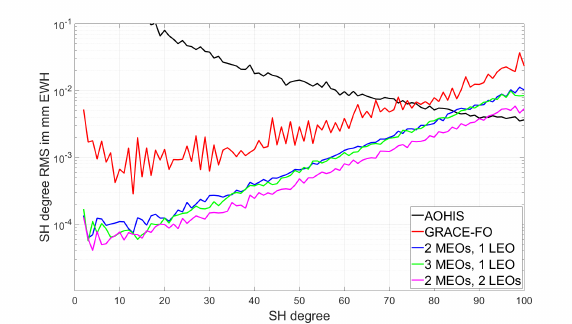
Fig. 5. Degree (error) RMS of full AOHIS signal (black) and different mission scenarios, when including only instrument errors.